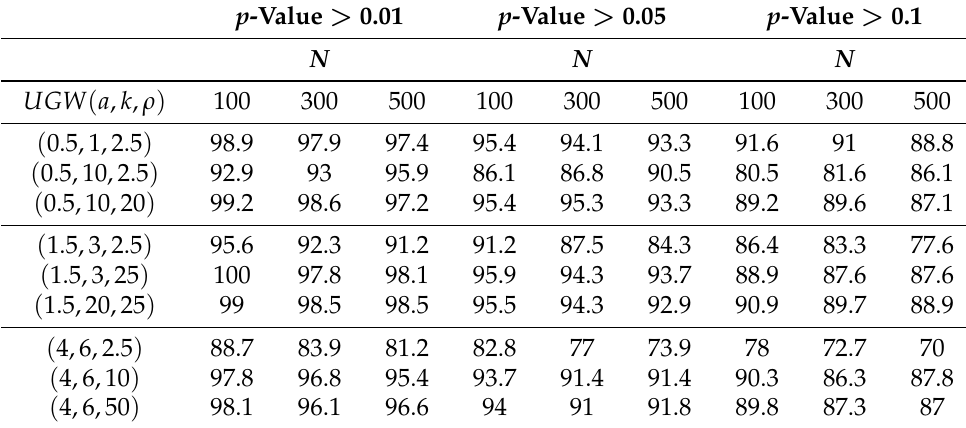
Table 2. Percentage of samples that come from a EBW model at the 1%,5% and 10% significance levels according to the χ 2 -goodness of fit